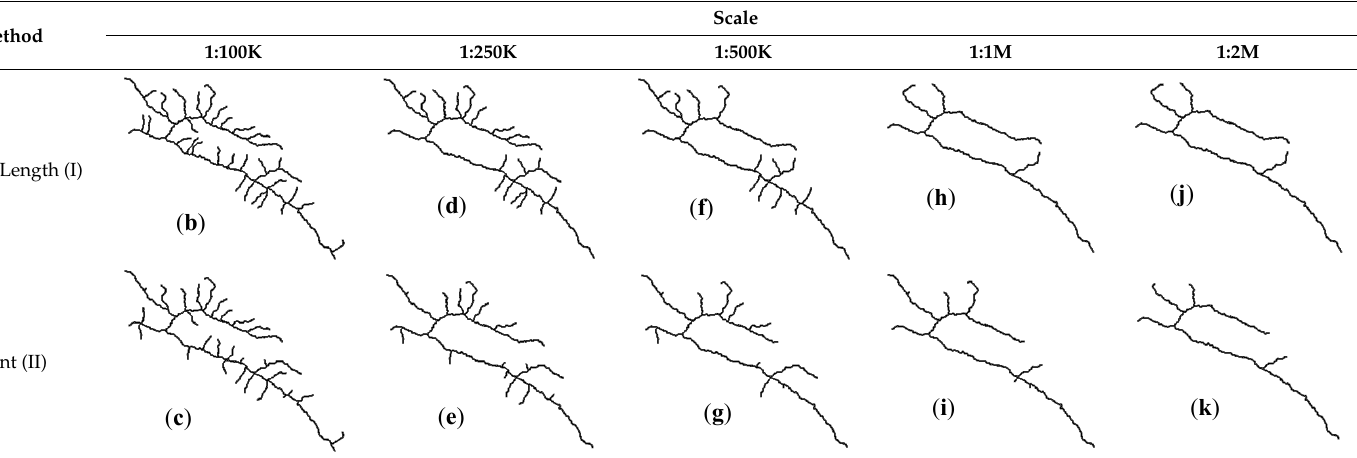
Table 8. Generalized river network for trellis case at different scales.